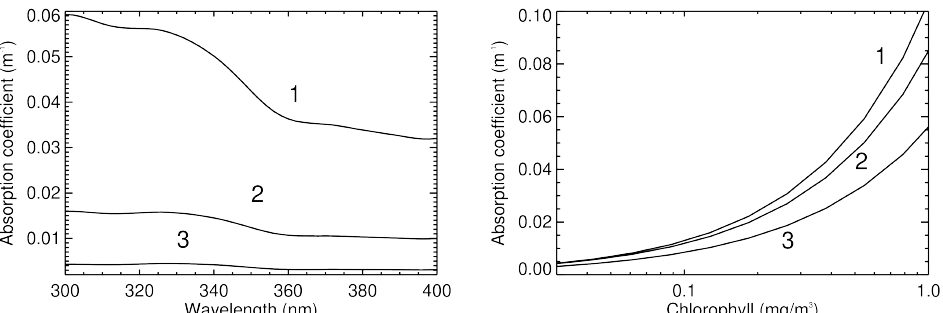
Figure A1. The particulate-matter absorption coefficient. Left panel: a ph as a function of wave- length for different chlorophyll concentrations: 1—Chl = 0.55mg/m 3 ; 2—Chl = 0.13mg/m 3 ; 3— Chl = 0.03mg/m 3 . Right panel: a ph as a function of chlorophyll concentration for different wave- lengths: 1–300nm; 2–340nm;